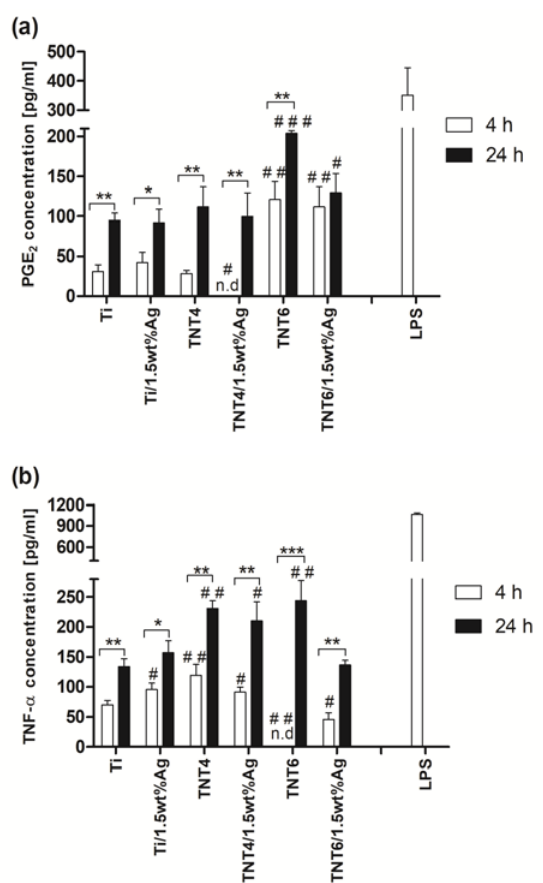
Figure 6. The concentration of prostaglandin E 2 (PGE 2 ; a ) or tumor necrosis factor α (TNF- α ; b ), in the final supernatants harvested after the incubation of peripheral blood mononuclear cells (PBMCs) with the TNT/Ag coatings, detected by the ELISA assay. Levels of PGE 2 and TNF- α were assessed for PBMCs incubated for 4 h and 24 h with titanium substrate (Ti), titanium substrate enriched with silver nanoparticles (Ti/1.5 wt% Ag), TNT4, and TNT6 coatings loaded or not loaded with silver nanoparticles (TNT/1.5 wt% Ag or TNT, respectively). PBMCs stimulated with LPS (1 µg/mL) for 4 h were used as a positive control for assessing the PGE 2 and TNF- α release capacity of cells. Data are shown as means ± standard error mean (S.E.M.) of three independent experiments with two wells each. Asterisk indicates significant differences between the fibroblasts incubated with the respective biomaterial samples for 4 h (white column) in comparison to the 24-h incubation time (black column; * p < 0.05, ** p < 0.01, *** p < 0.001). Hash mark denotes significant differences between the cells incubated with titanium substrate (Ti) for 4 h or 24 h compared to the cells incubated with TNT, TNT/Ag, or Ti/Ag for the same period (# p < 0.05, ## p < 0.01, ### p < 0.001); n. d. — not detected.